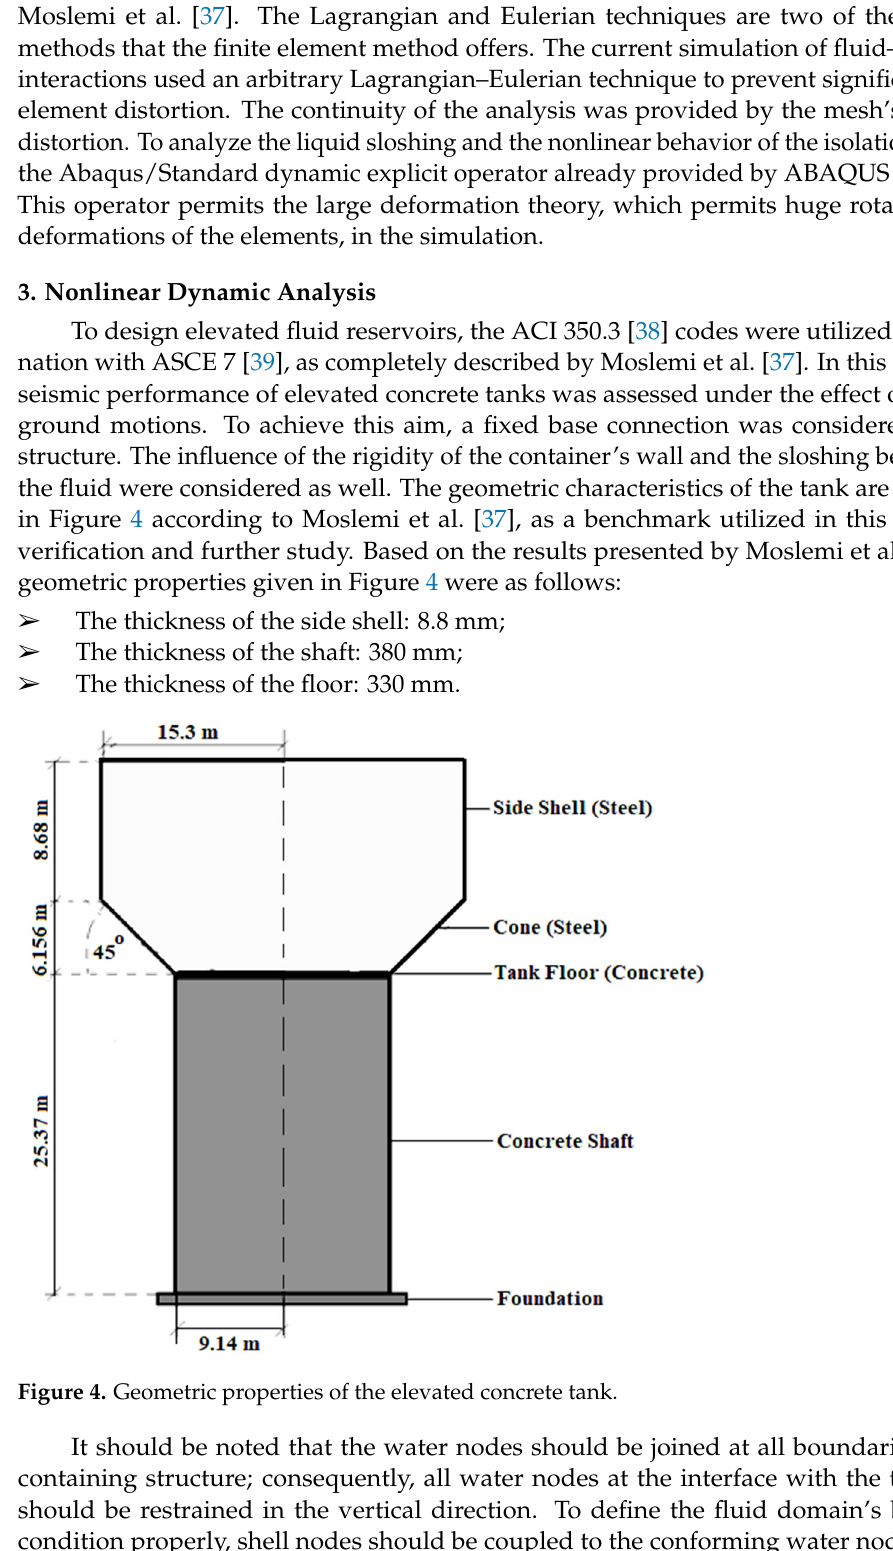
Figure 5. FEM representation of the elevated tank model. 4. Verification To show the ability and efficiency of the proposed dynamic method, the model was verified by the study of Moslemi et al. [37] study of the El Centro earthquake. As is shown